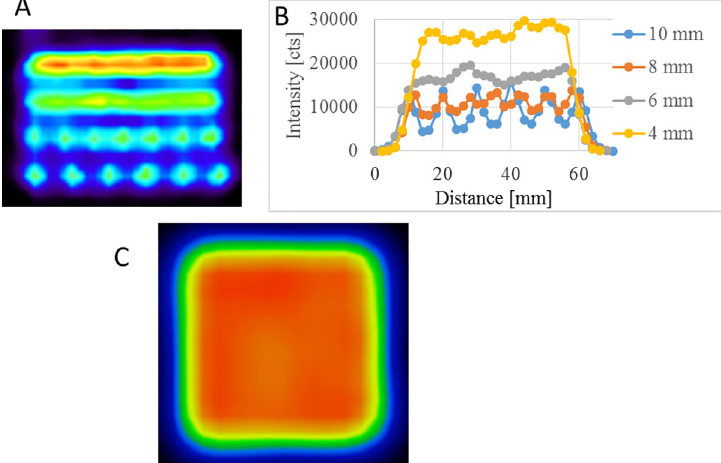
Fig 2. Step size optimization results. Lines having various step size (4, 6, 8, 10 mm) of the point source (A), derived line profiles (B) and transaxial slice of a 3-D homogeneous cube using 4mm step size between the point source movements (C).